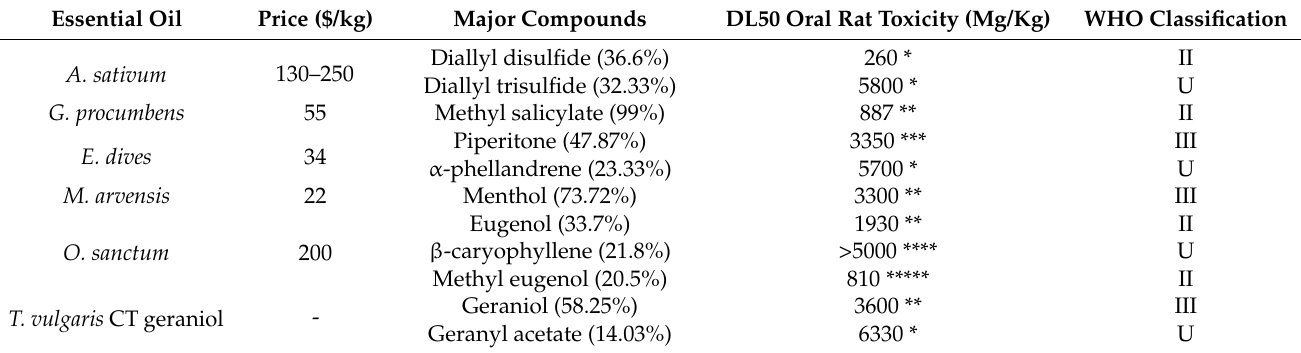
Table 5. Price of the most lethal oils tested and the mammal’s toxicity of their major